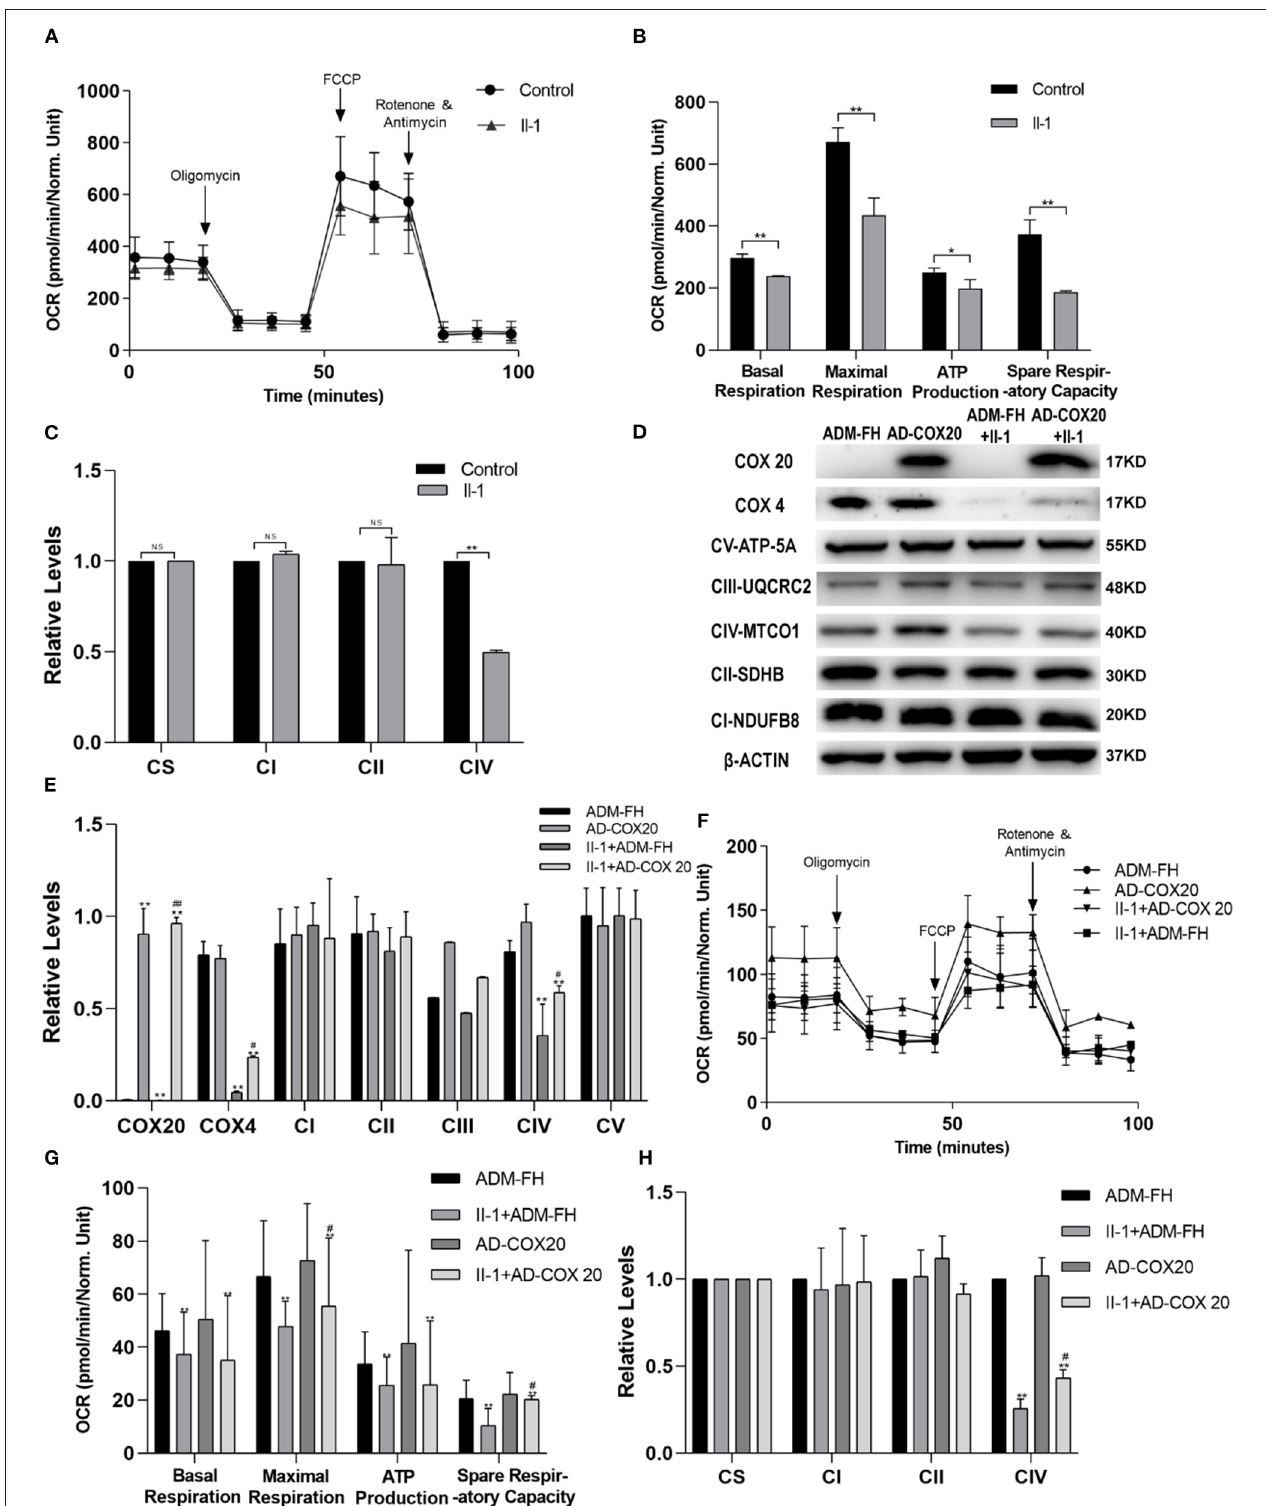
FIGURE 4 | (A,B) OCR of patient (II-1) fibroblasts was measured using a Seahorse XF24 Extracellular Flux Analyzer. Basal respiration, maximal respiration, ATP production, and spare respiratory capacity of fibroblasts from the patient are significantly lower than those of control. (C) To detect the enzymatic activities